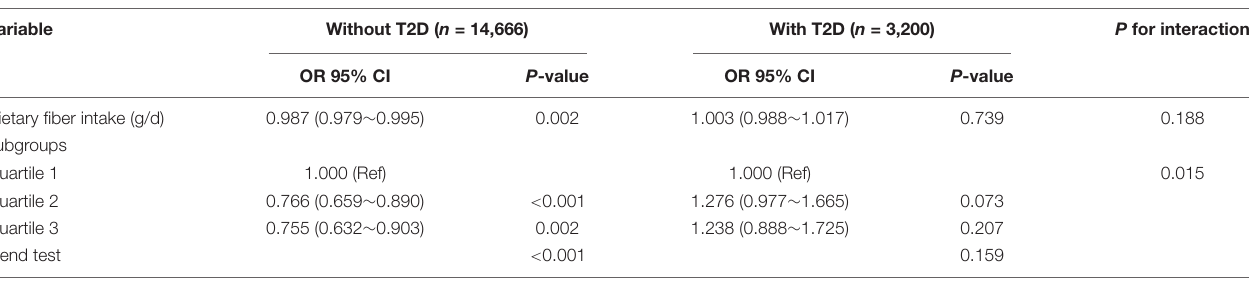
TABLE 4 | Interactive effect of dietary fiber intake and depression in patients with or without type 2 diabetes (T2D). Variable Without T2D ( n = 14,666) With T2D ( n =